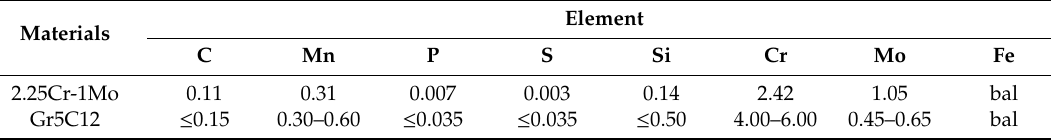
Table 1. Nominal compositions of tribo-pairs in